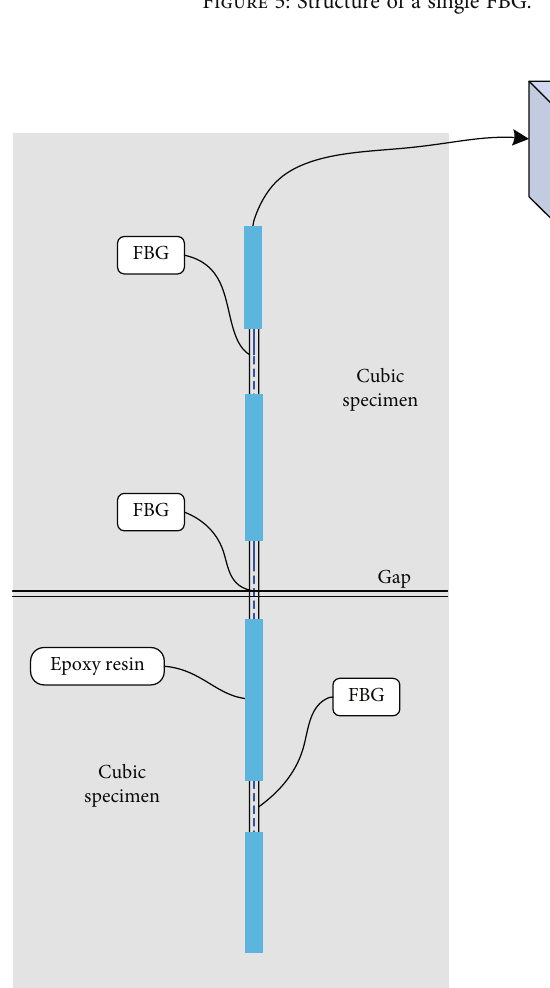
Figure 6: Vertical placement of the three-series FBGs.